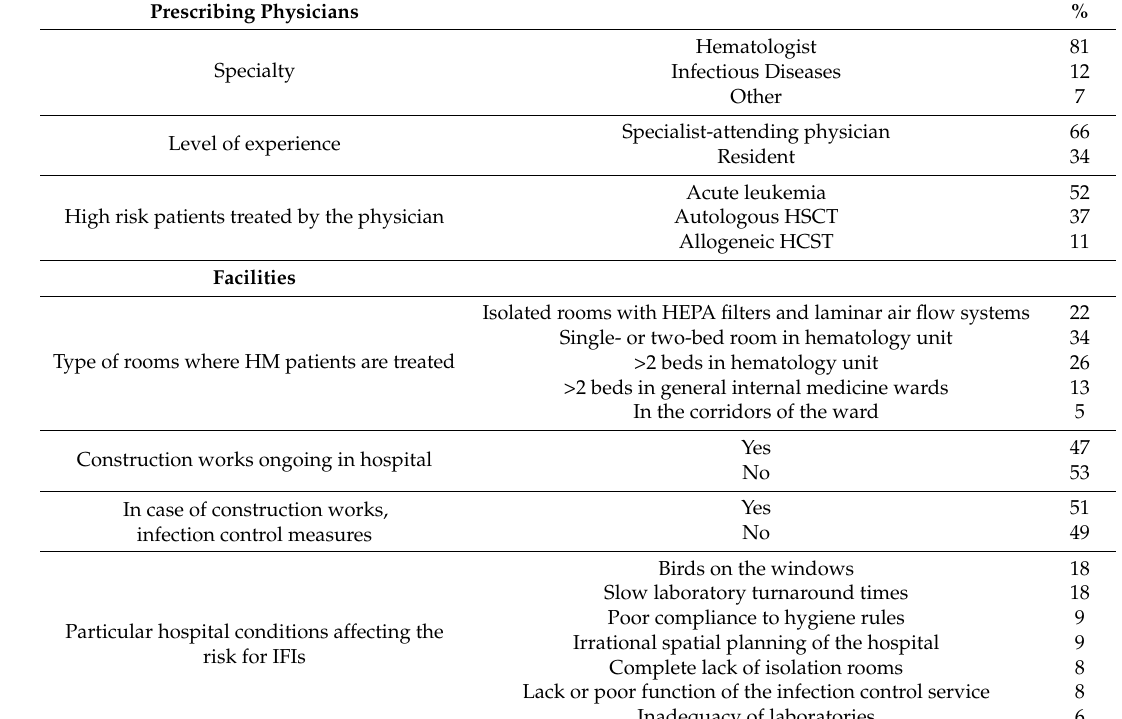
Table 1. Prescribing physicians, facilities, and hospital conditions affecting the risk for and management of invasive fungal infections (IFIs) in Greek